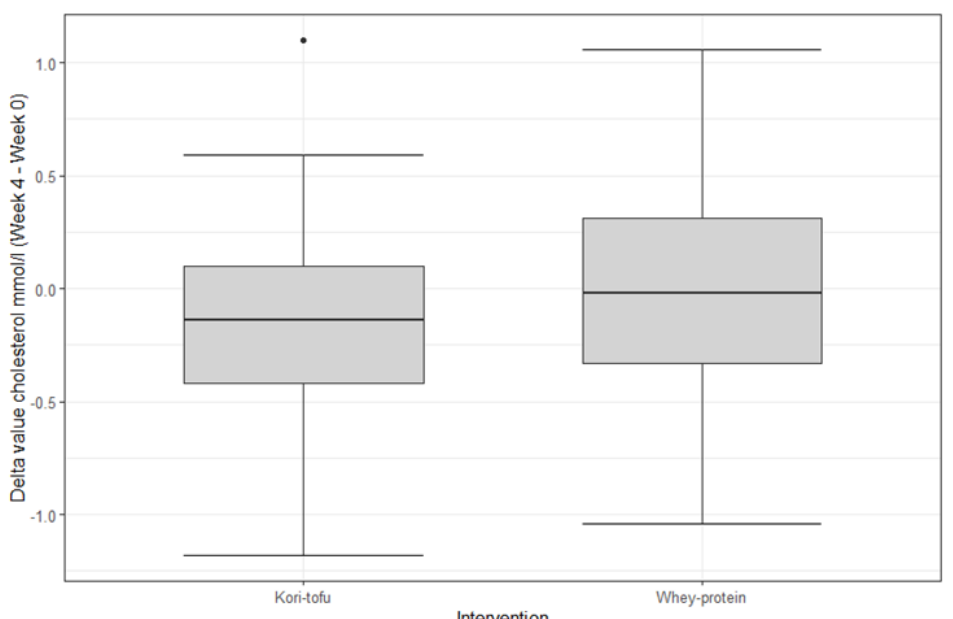
Figure A1. Delta values of total cholesterol (mmol/L) per intervention (values week 4–values week 0). Boxplots represent the 25th, 50th (median) and 75th percentile. Antennas represent 1.5 times interquartile range. Dots represent values outside the 1.5 times interquartile range.